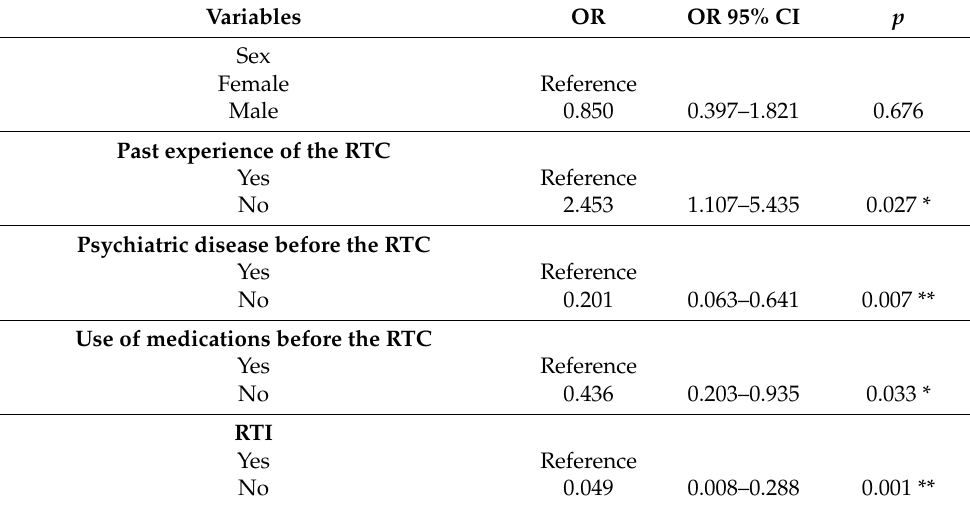
Table 6. The multivariable regression model for PTSD symptoms at 1-month follow-up.